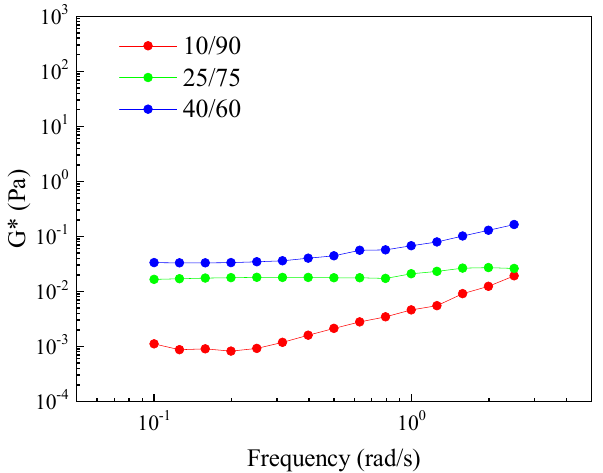
Figure 5. Complex moduli (G*) of multiple emulsions as a function of frequency obtained for three different (W 1 /O)/W 2 ratios for the secondary emulsion: 10/90, 25/75 and 40/60.